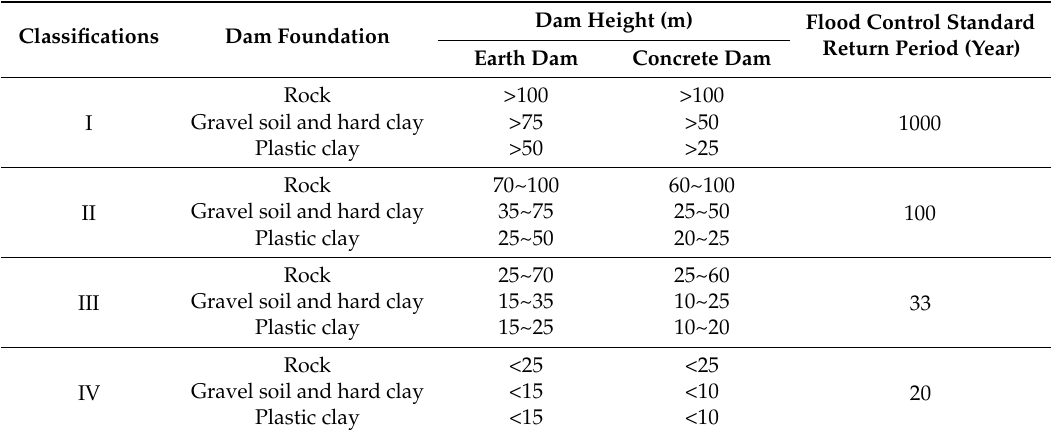
Table 7. Flood control standard for reservoir engineering of former Soviet Union.